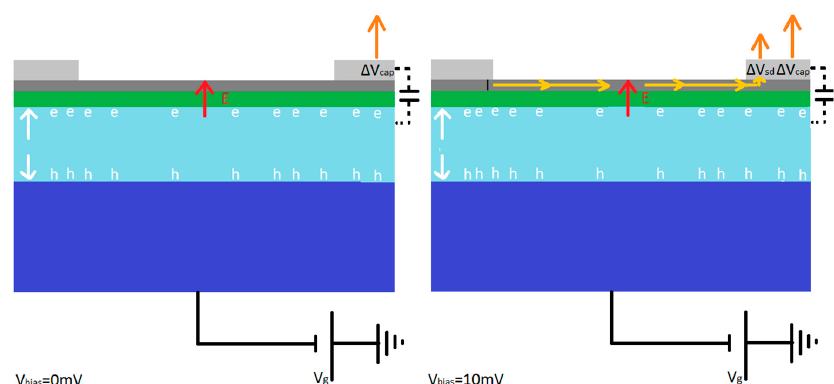
Figure 14. showing the different contributions to the signal that we obtain, with only a contribution from the capacitative coupling between the absorber and contact for V bias = 0 mV, and the capacitative coupling contribution and from the change in voltage across the graphene providing an additional voltage pulse when V bias = 10